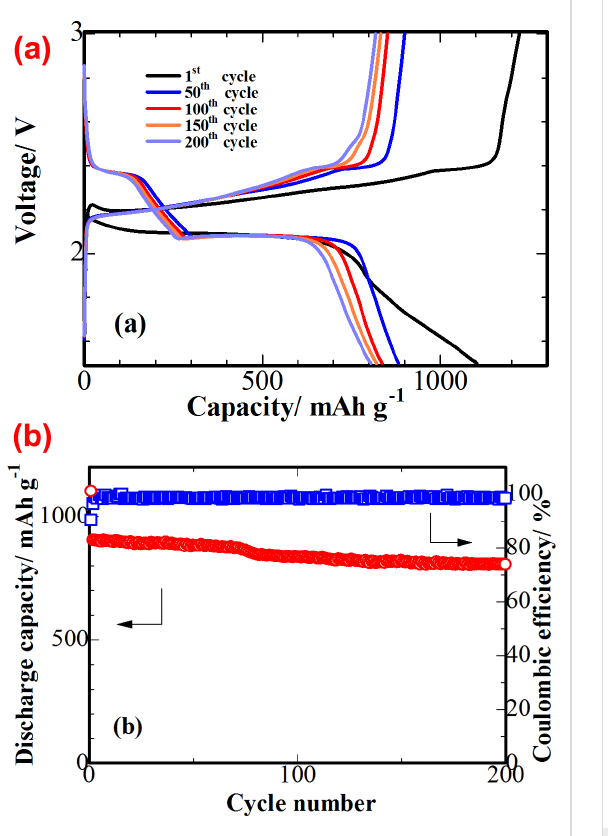
Figure 7: (a, b) Specific capacity and rate performance of S-3D- RGO@MWCNT cathode at different C-rate, ranging from 0.1 C to 2 C . The changes in the conductivity during cycling a Li–S battery equipped with the S-3D-RGO@MWCNT cathode, were investi- gated using electrochemical impedance spectroscopy